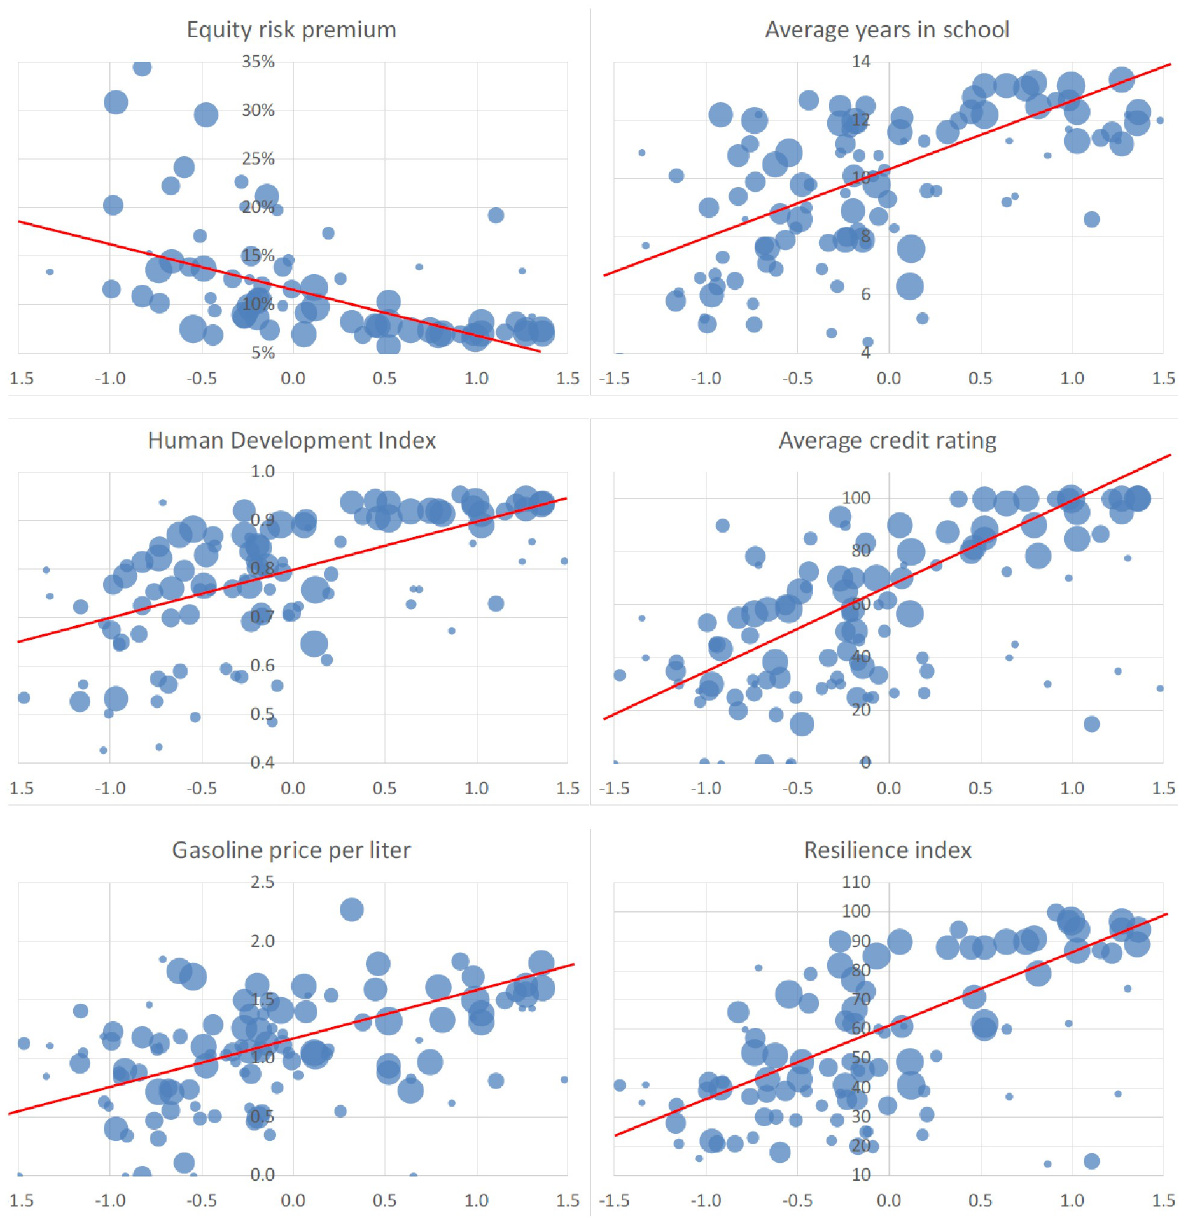
Fig 2. Bubble plots of various variables and universal preferences for time (UP time, on the x-axis). In most cases, we can see a clear dependence. The sizes of the bubbles correspond to the weight of the country data. Weighted regression lines in red.